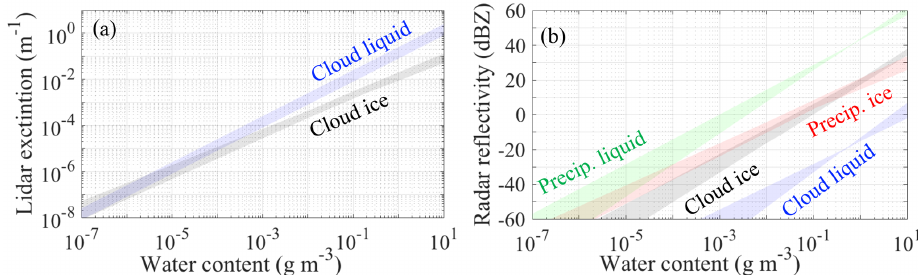
Figure 3. Relationship between water content in the form of cloud liquid (blue), precipitating liquid (green), cloud ice (black) and precipitat- ing ice (red) and (a) lidar extinction, and (b) radar copolar reflectivity. Spread emerges from using multiple differing empirical relationships (listed in Table 2) and from variability in the 1-year ModelE output (including the effects of varying temperature and effective